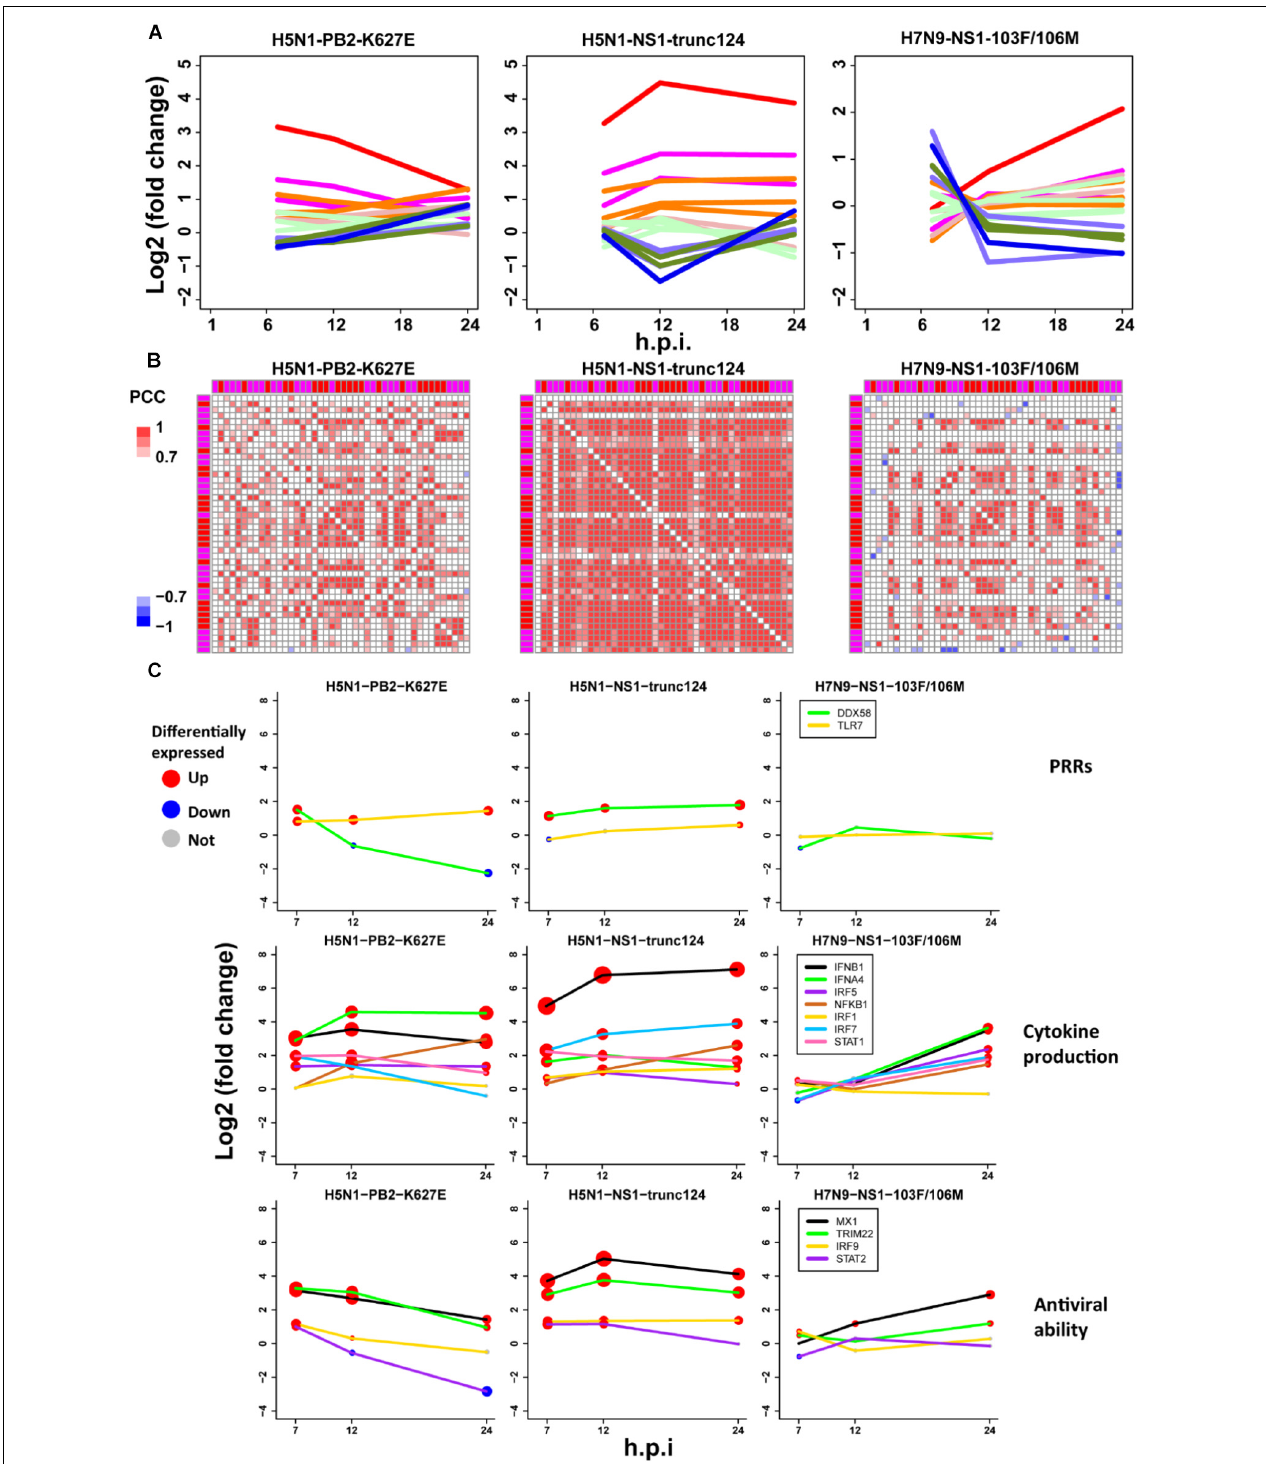
FIGURE 7 | Validation of the pathogenesis model using avian IAV mutants. (A) Expression trends of all ASGs. The line colors have the same meanings as those of Figure 2D . (B) Expression correlations between the 44 early upregulated ASGs. The annotation colors and gene order are the same as those of Figure 3B . (C) Dynamic expression levels of key genes involving the pathogenesis model. The node size represents significance of gene differential expression, and the node color represents up-regulation (red), down-regulation (blue) or not significant (gray).